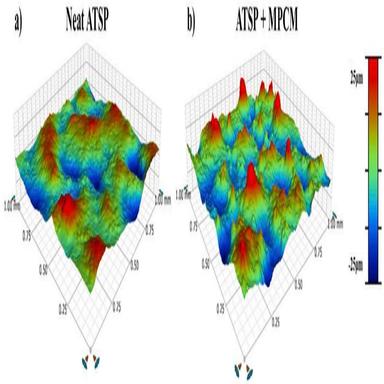
3D representation (1 mm × 1 mm) of (a) neat ATSP and (b) ATSP + MPCM samples.